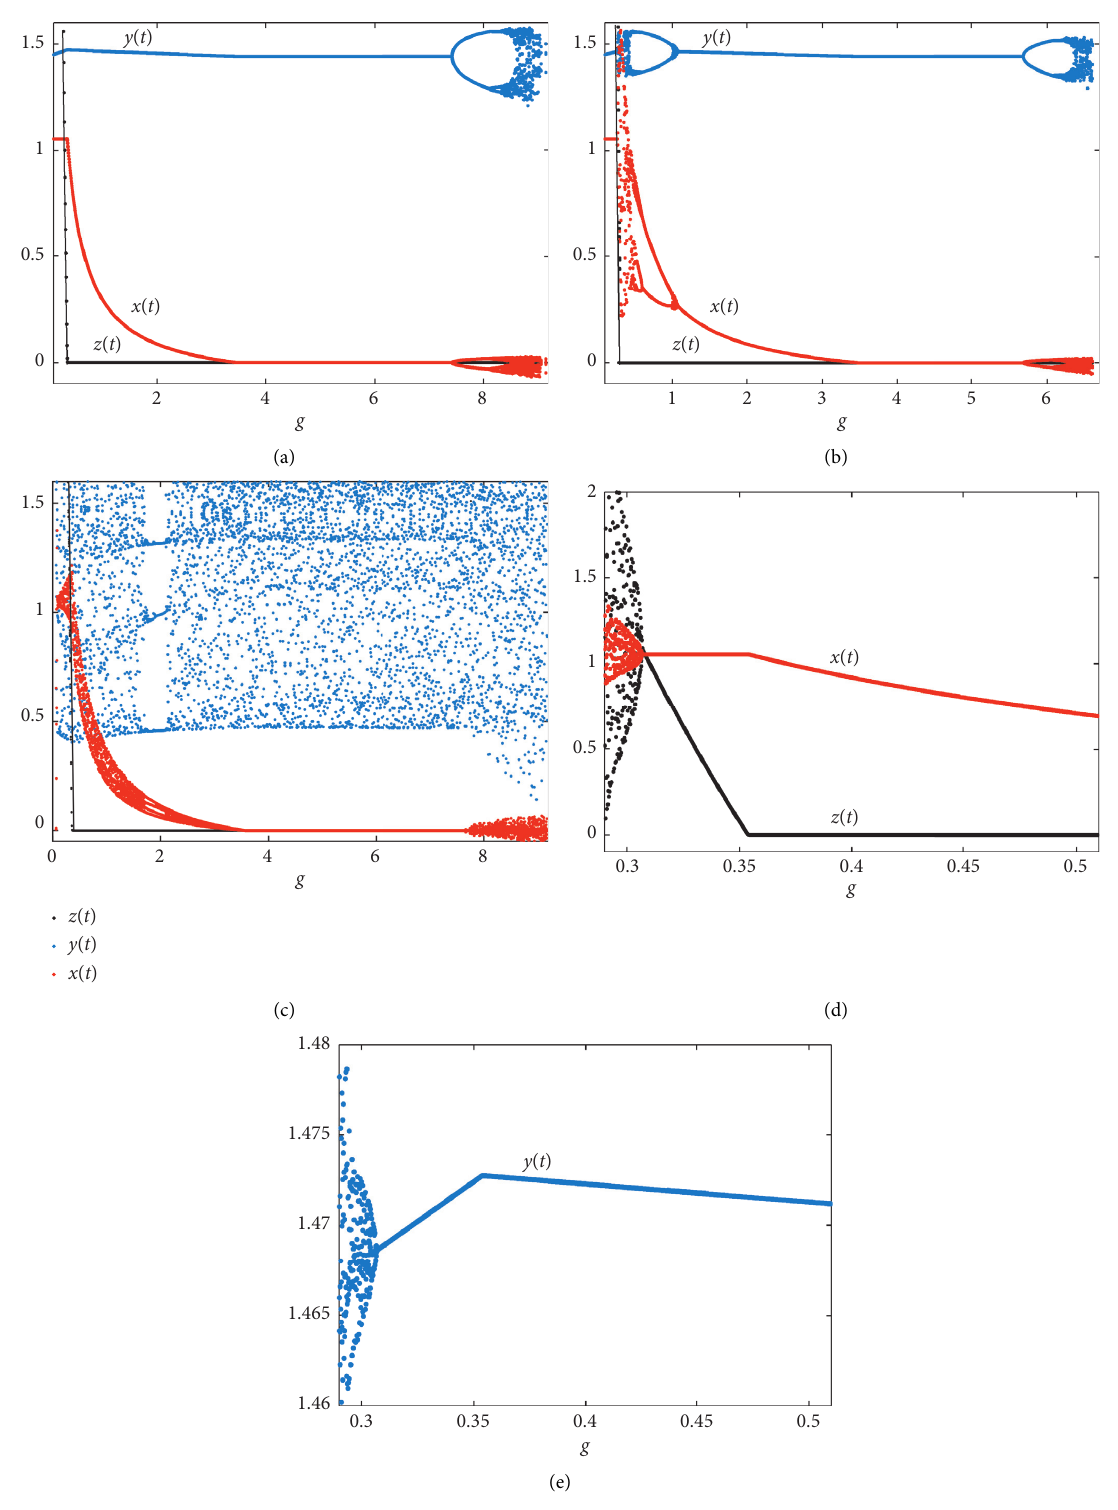
Figure 17: Bifurcation diagram with respect to g : (a) α � 0 . 7 , α � 0 . 315 , and α α 1 2